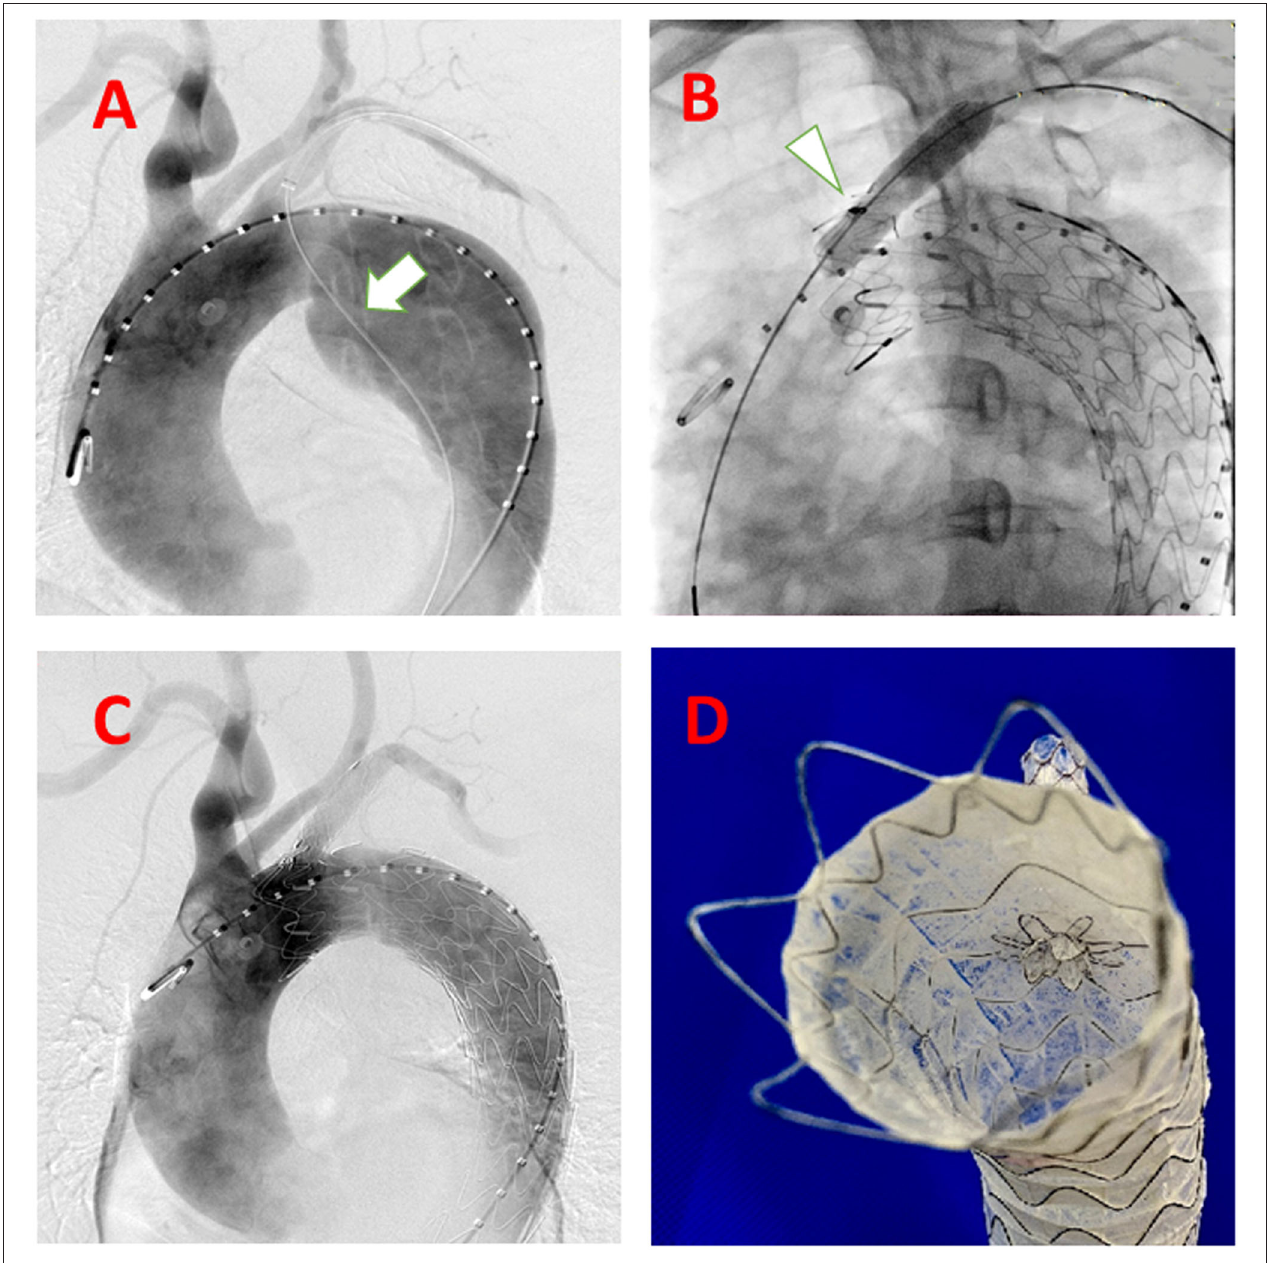
FIGURE 2 | Steps of the system accomplished delivered in the human case. (A) guidewire (white arrow) from LSA to the descending aorta to the femoral artery as a strengthen wire, which makes puncture angle from LSA to aortic stent-graft more friendly; (B) After balloon expansion (white arrow) of the deployed C-skirt stent-graft; (C) DSA after the whole procedure accomplished; (D) Real view of the C-skirt stent-graft in the aortic stent graft.